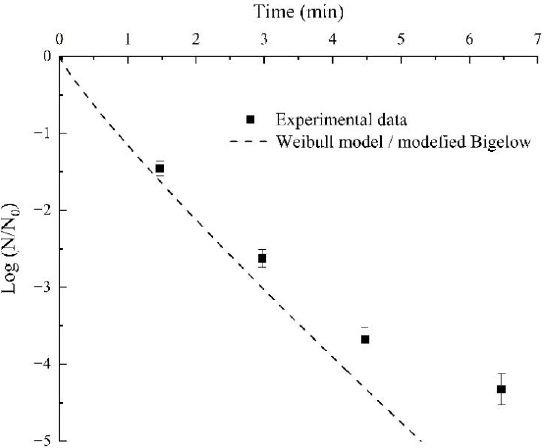
Figure 8. Experimental data and predicted survival curves for the target Aspergillus inoculated into almond kernel flour with 0.854 a w at 68 °C by combining the Weibull model with Mafart’s modified Bigelow equation.